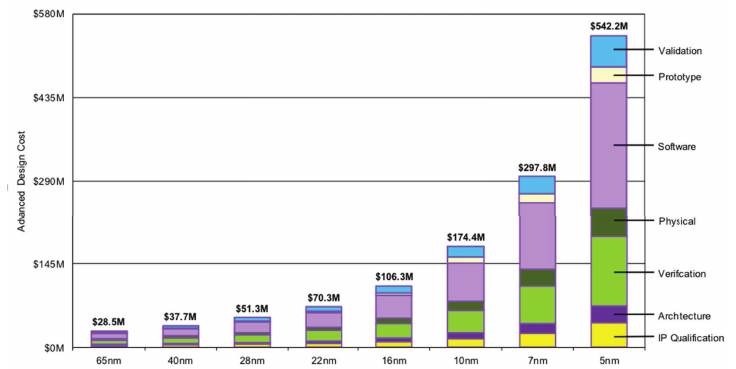
Figure 1. Chip Design and Manufacturing Cost under Different Process Nodes: Data Source from IBS